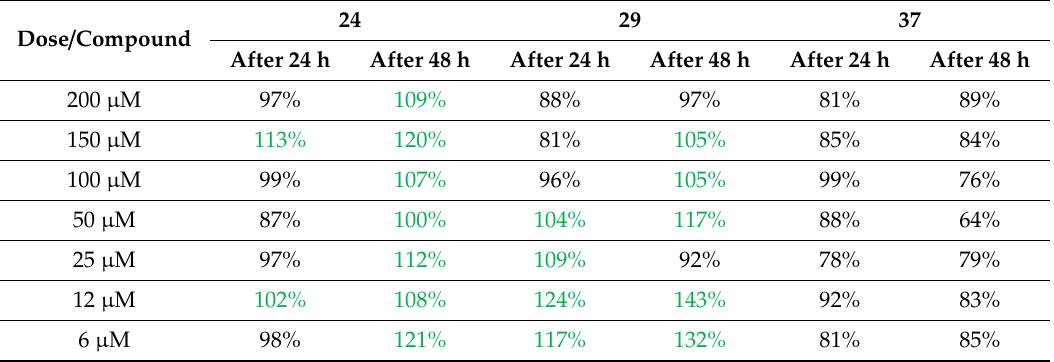
Table 3. The cell proliferation in % according to control after 24 h and after 48 h exposition on studied compounds in L929 cell